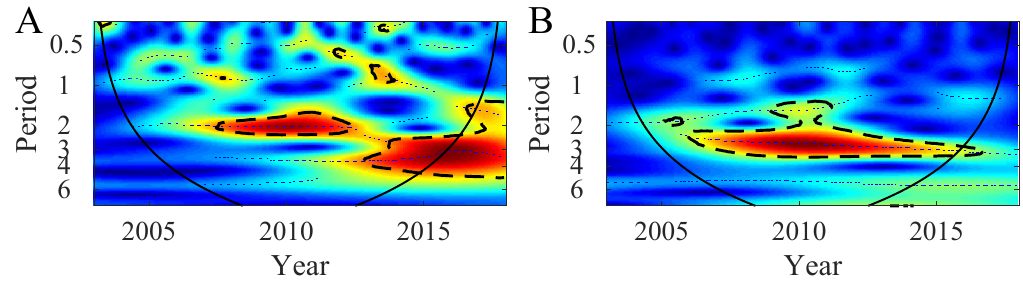
Figure 3. Wavelet Power Spectrum as defined in Figure 2 but for ( A ) SAM and ( B )